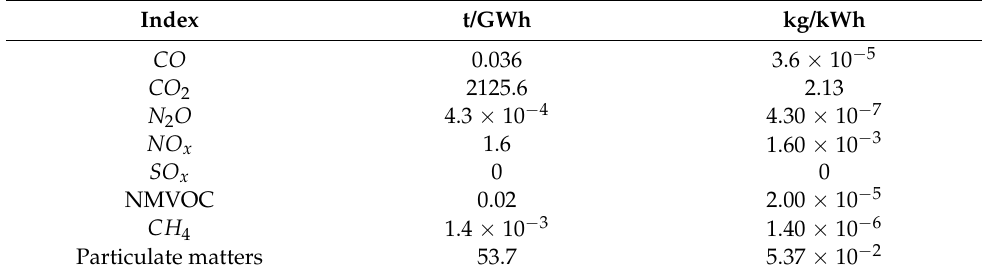
Table 4. Emissions index.